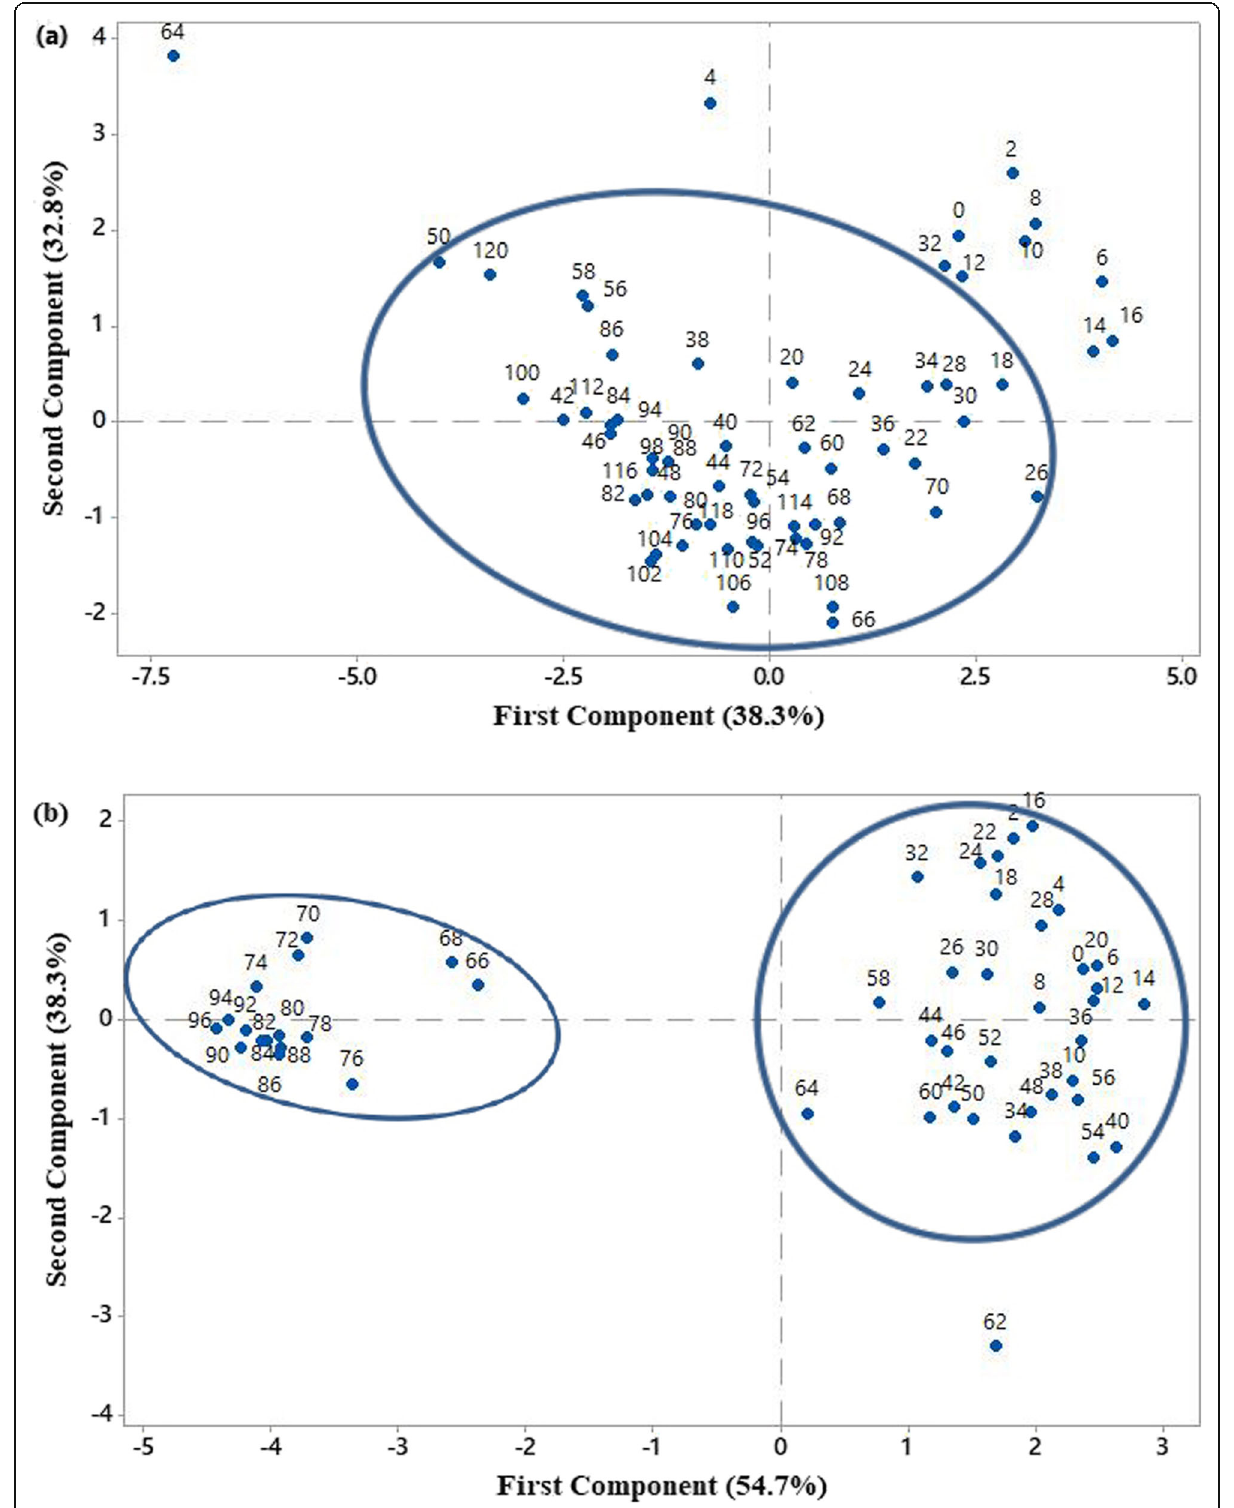
Fig. 5 Loading plot of selected metals concentrations vs depth on KR1 ( a ) and KR2 ( b